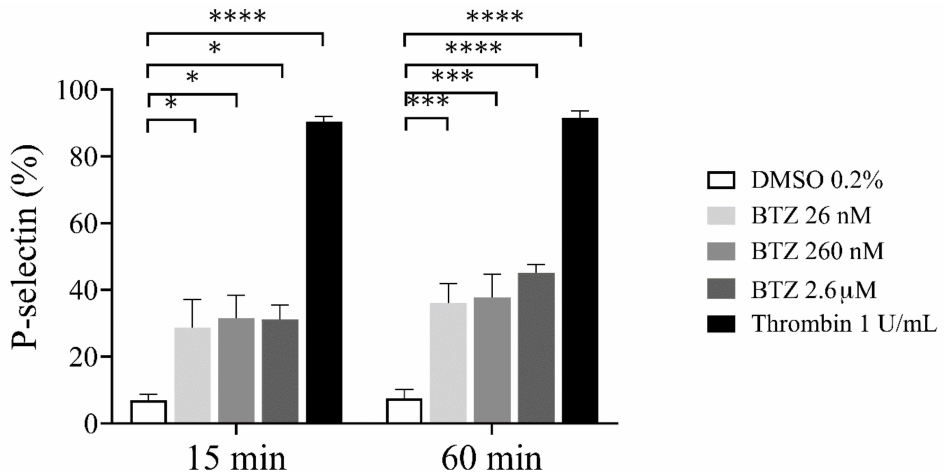
Figure 2. P-selectin expression in BTZ-preincubated human GFPs. GFPs were treated with BTZ, thrombin (positive control) and DMSO (negative control) for 15 and 60 min. P-selectin expression was analyzed by flow cytometry using anti-CD62P antibody. Mean ± SEM of 5 independent experiments is presented. The level of significance at both 15 and 60 min of treatment was determined using ANOVA and Dunnett’s multiple comparisons test; * p < 0.05, *** p < 0.001 and **** p < 0.0001 compared to the DMSO group. BTZ: bortezomib; DMSO: dimethyl